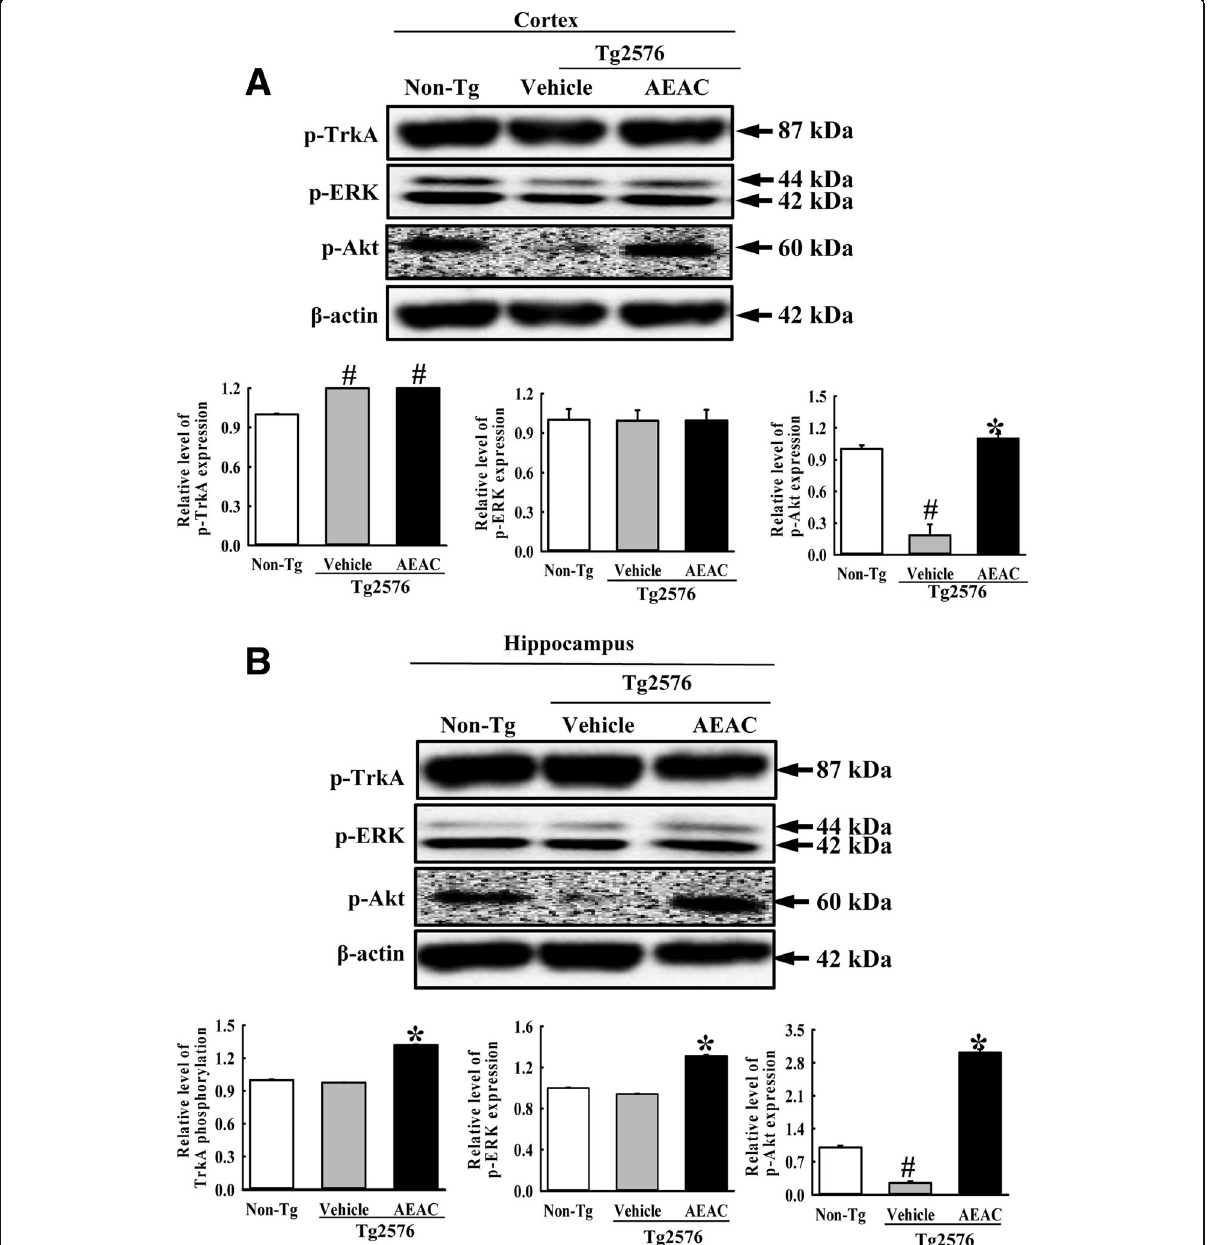
Fig. 4 Downstream signaling pathway of TrkA NGF receptor. Tissue lysates were prepared from the cortex a and hippocampus b of Tg2576 mice treated with vehicle or AEAC as described in the Methods. Fifty micrograms of protein per sample was immunoblotted with antibodies for each protein. Three samples were assayed in triplicate by Western blotting. Data are reported as the means ± SD. # , P < 0.05 compared to the Non-Tg group. *, p < 0.05 compared to the Vehicle treated Tg2576